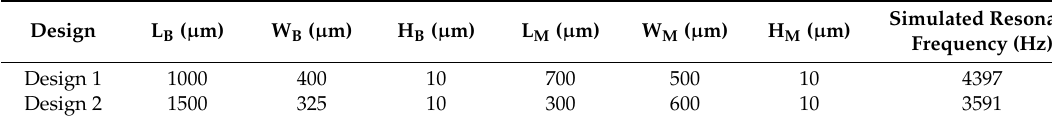
Table 3. Fabricated Design Parameters. Figure 11. SEM micrograph of the fabricated harvesters Design 1 (bottom) and Design 2 (top).